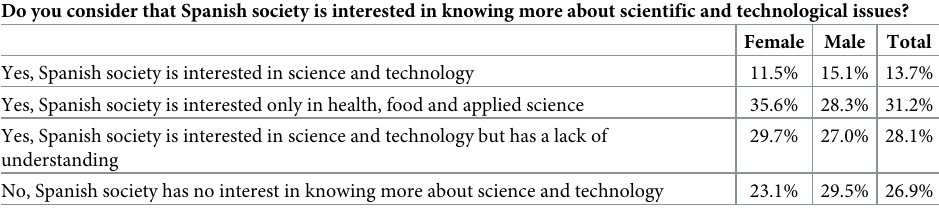
Table 3. Scientists’ views of public interest in science and technology (total and according to gender).